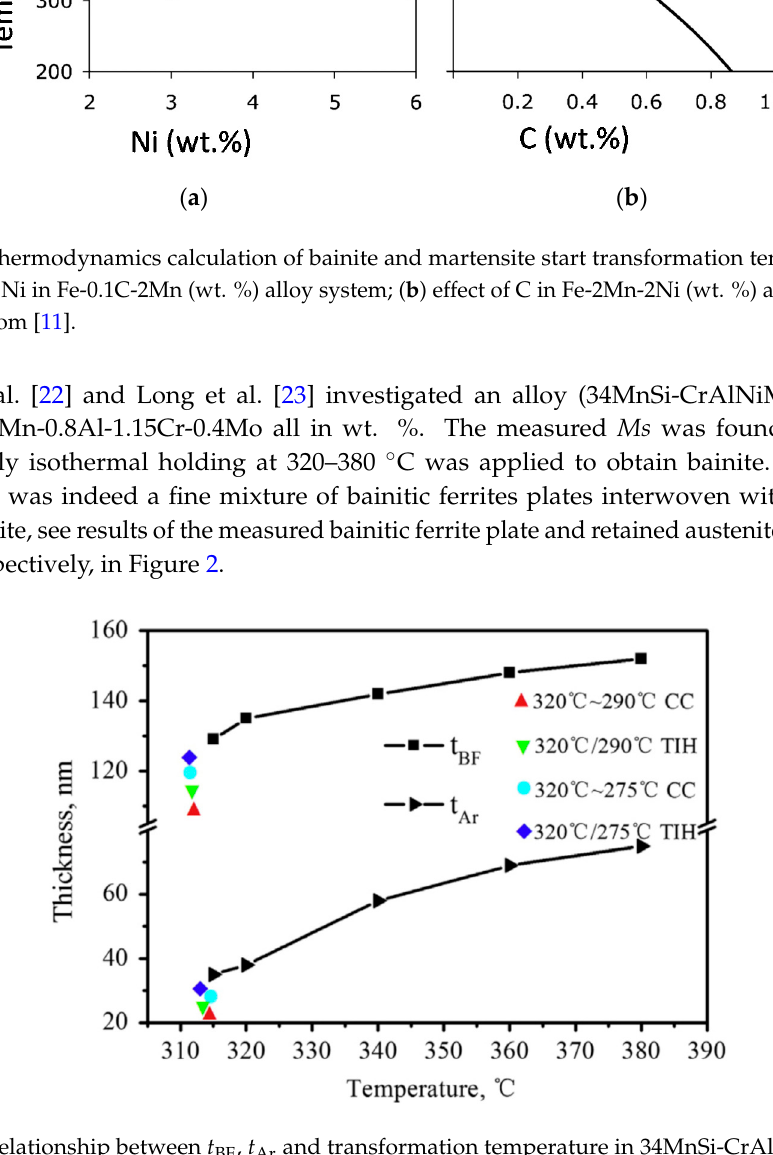
Figure 1 . Thermodynamics calculation of bainite and martensite start transformation temperatures: ( a ) effect of Ni in Fe-0.1C-2Mn (wt. %) alloy system; ( b ) effect of C in Fe-2Mn-2Ni (wt. %) alloy system. Adapted from [11].